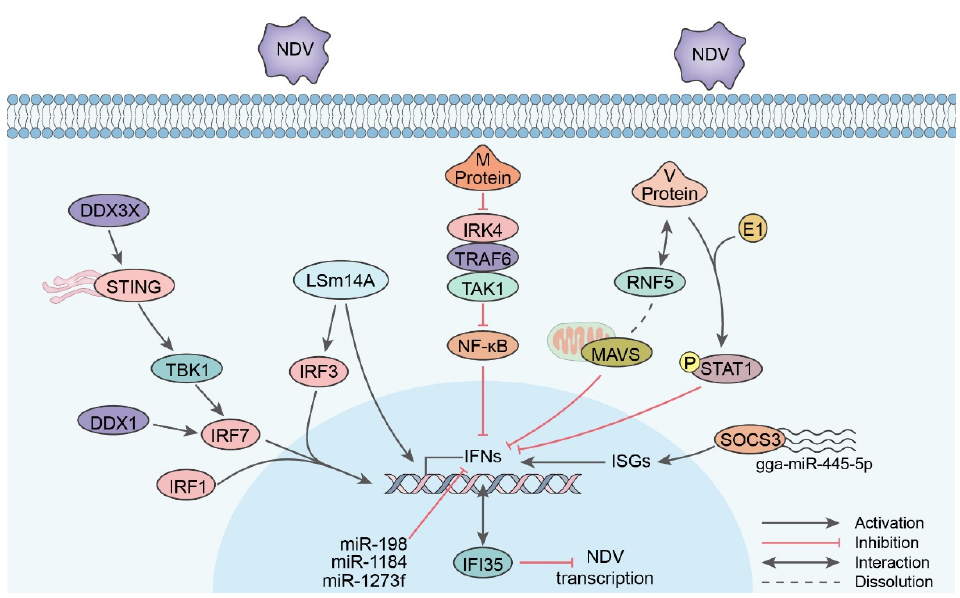
Figure 1. Signal pathway of IFN secretion caused by NDV